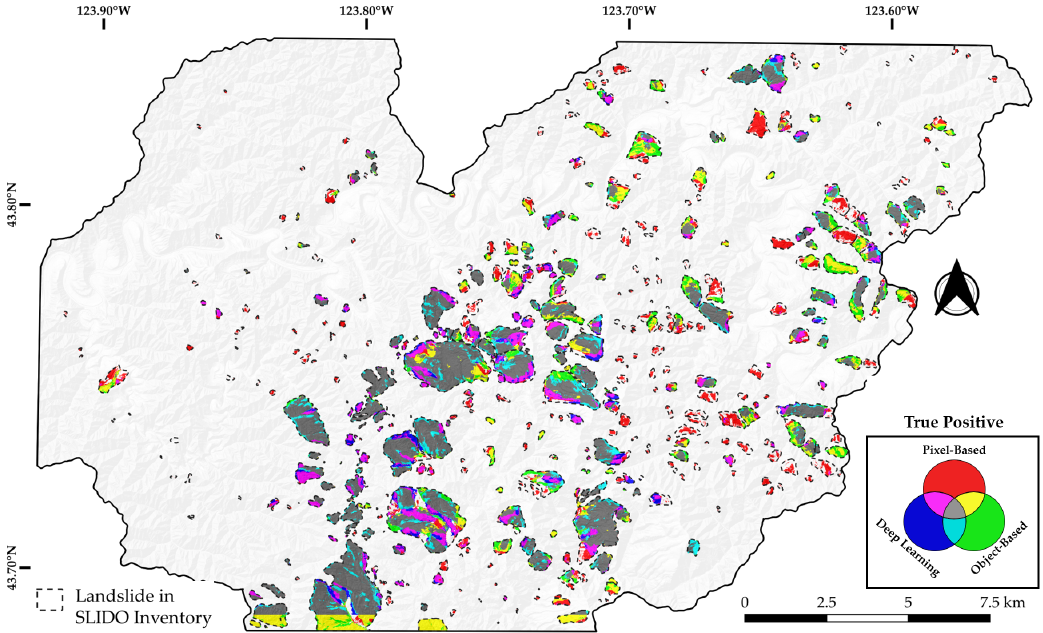
Figure 8. True positive predictions of all the three machine learning methods (i.e., pixel-based with RF, object-based with ANN and U-Net with ResNet34 backbone) on testing area. As described by the legend in the bottom-right, the primary colors represents the true positive prediction by only one method, while the secondary colors represents the true positive prediction by the combination of two methods. Gray coloured areas are true positive prediction by all the three methods. The map is in UTM Zone 10N with WGS 84 datum (EPSG:32610).